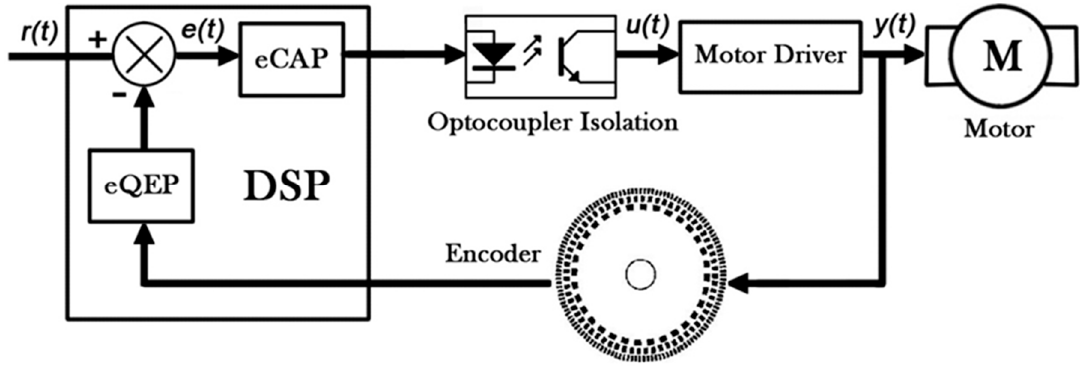
Figure 4. Schematic of the closed-loop control on the motor rotation.